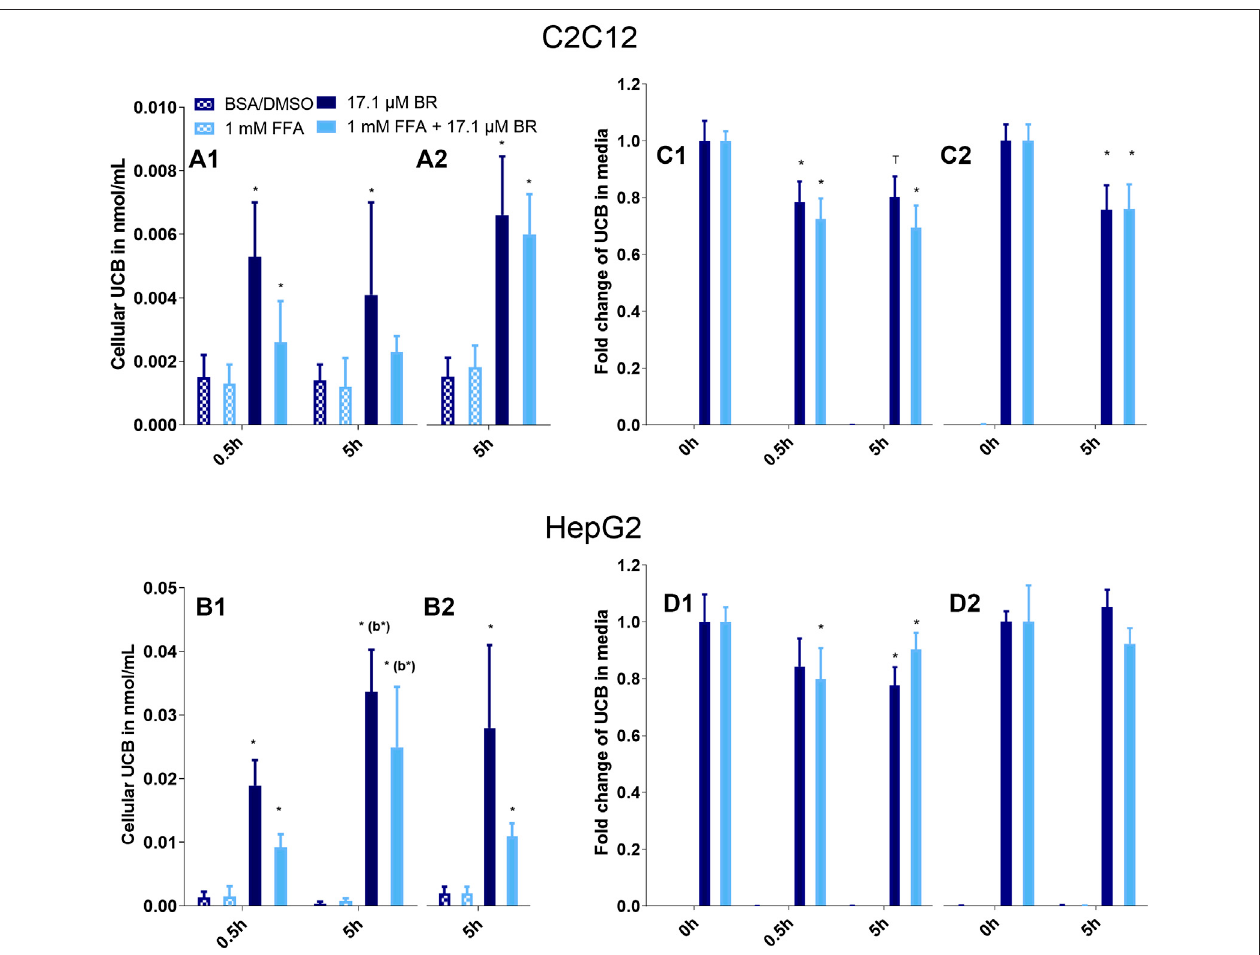
FIGURE 1 | UCB signi fi cantly increased the cellular UCB content of (A) C2C12 and (B) HepG2 cells and UCB concentration in the incubation media of (C) C2C12 and (D) HepG2 cells dropped signi fi cantly after 0.5 and 5 h. Cells were incubated under ( 1 ) hypoglycaemic conditions or ( 2 ) with glucose. Data are mean ± SD of four independent replicates, * p ≤ 0.05 and T p ≤ 0.1 compared to cells treated without UCB, compared to media prior incubation or compared to b (cid:2) the preceding incubation